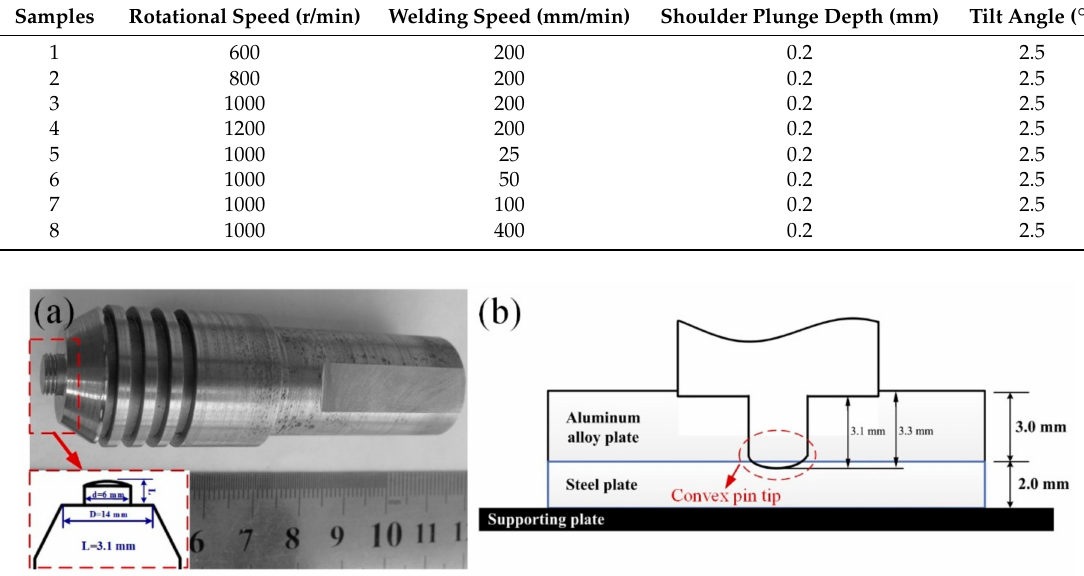
Figure 1. ( a ) The geometry shape and size of the designed tool; ( b ) the illustration of lap welding method.